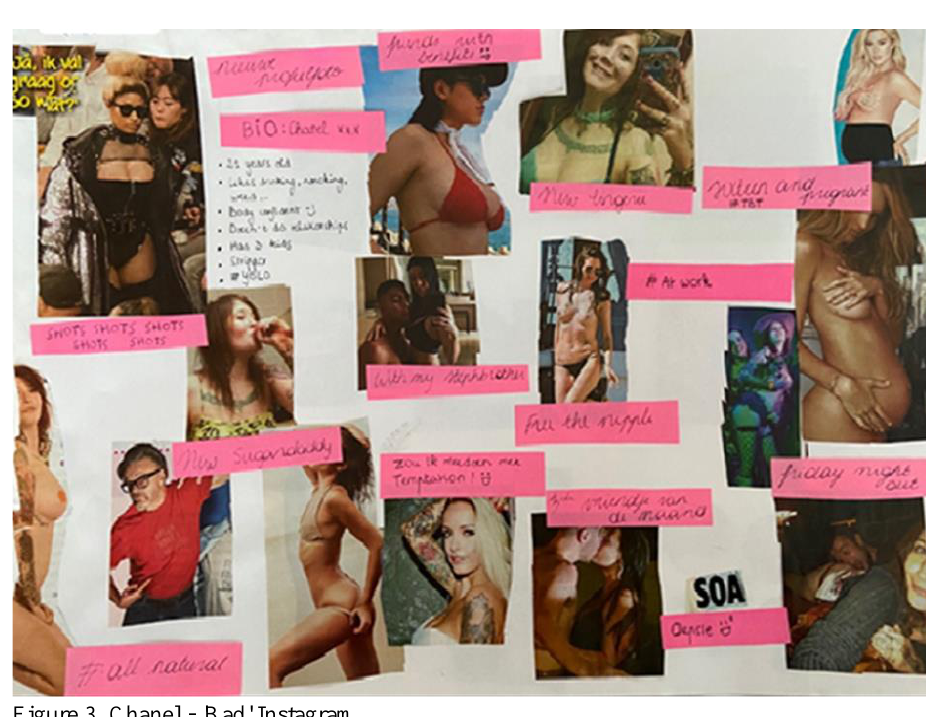
Figure 3. Chanel - 'Bad' Instagram